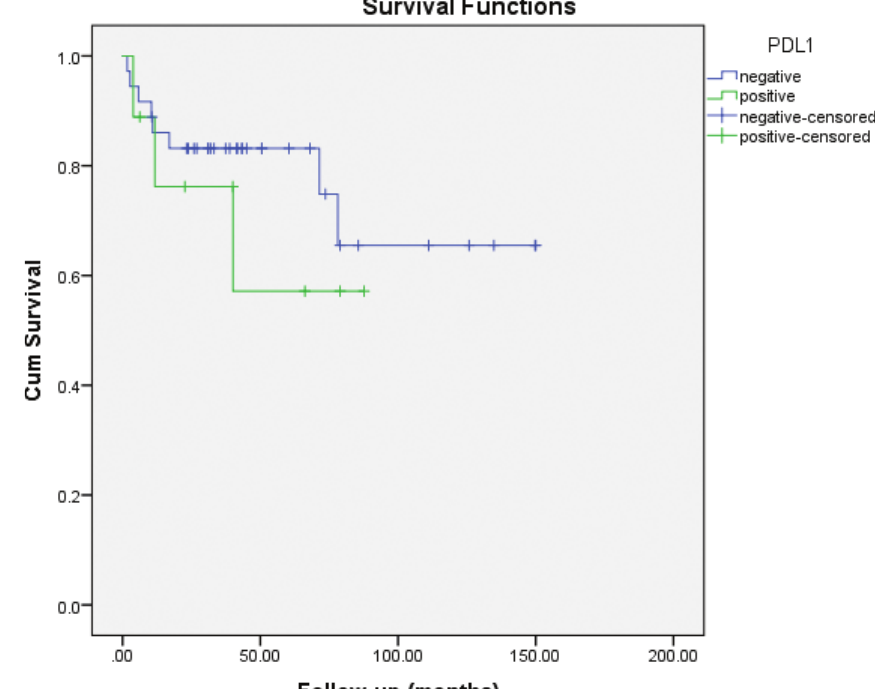
Figure 2. Kaplan–Meier plots of cancer-specific survival (CSS) according to PD-L1 expression status in non-ccRCC patients.